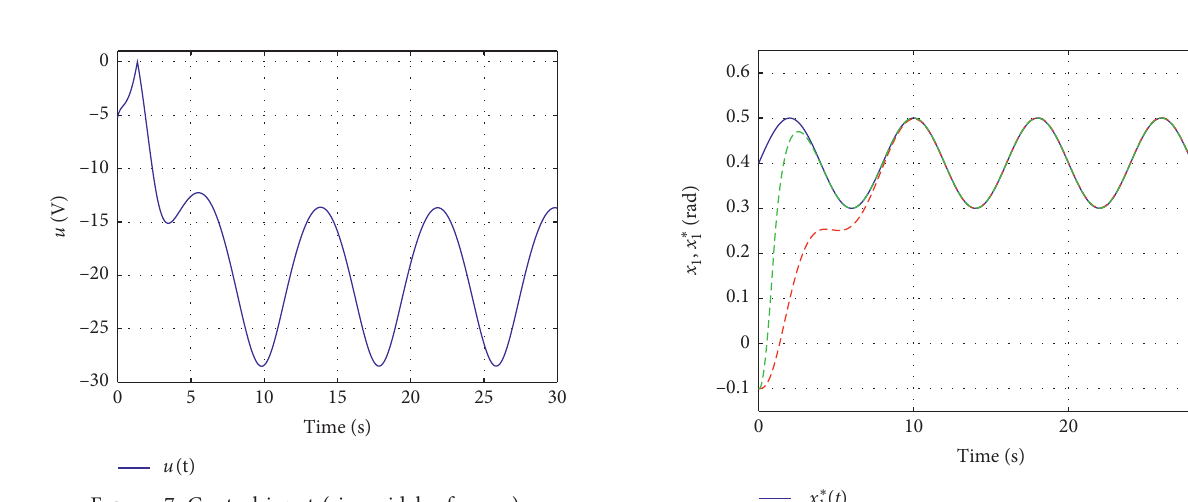
Figure 7: Control input (sinusoidal reference).